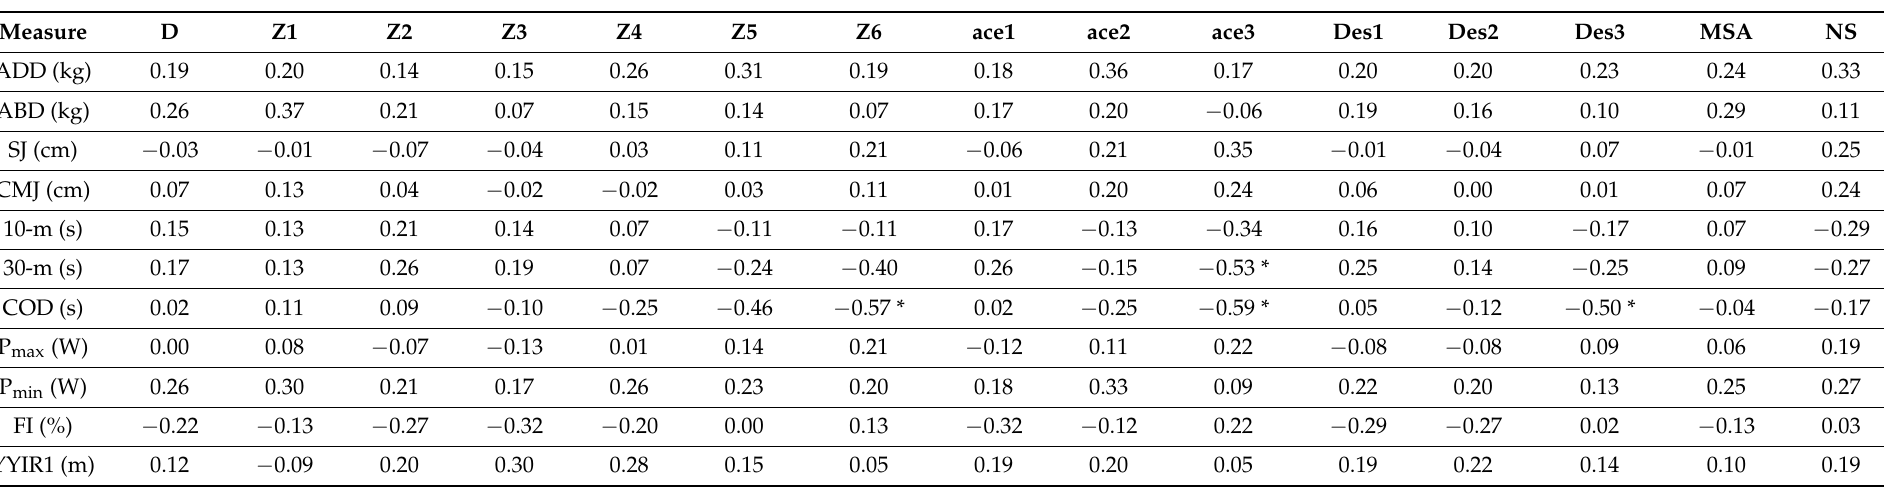
Table 3. Correlations between fitness assessment and match running (assessment 2 and matches